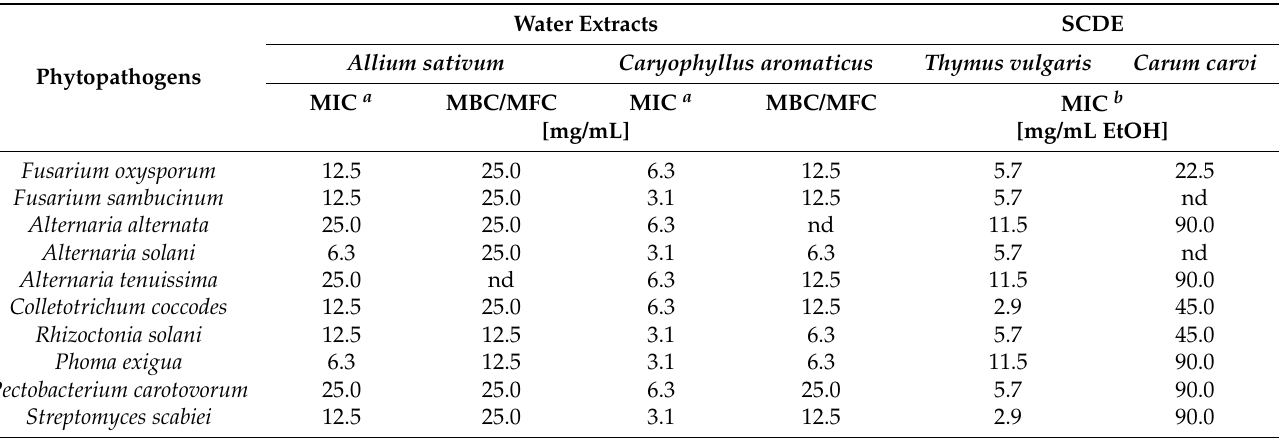
Table 1. MIC and MBC/MFC values of selected water and subcritical carbon dioxide extracts (SCDE) against potato